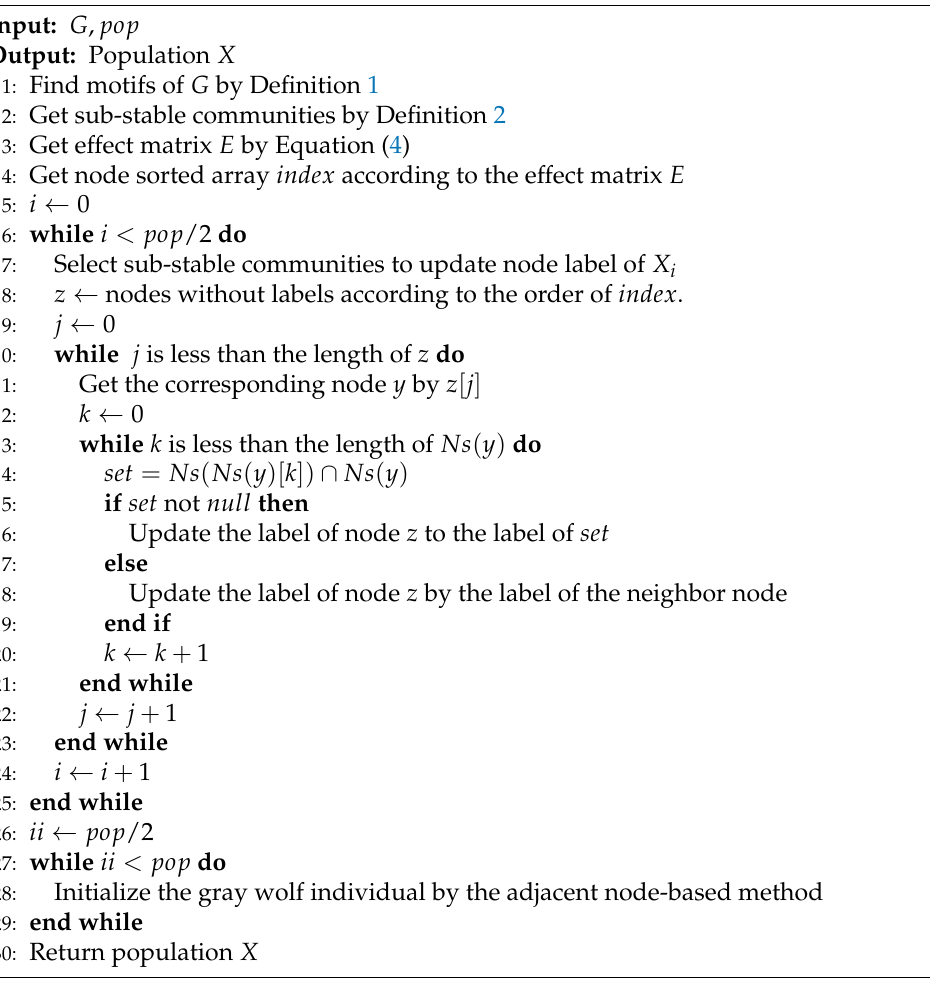
Algorithm 2 Fast elite population